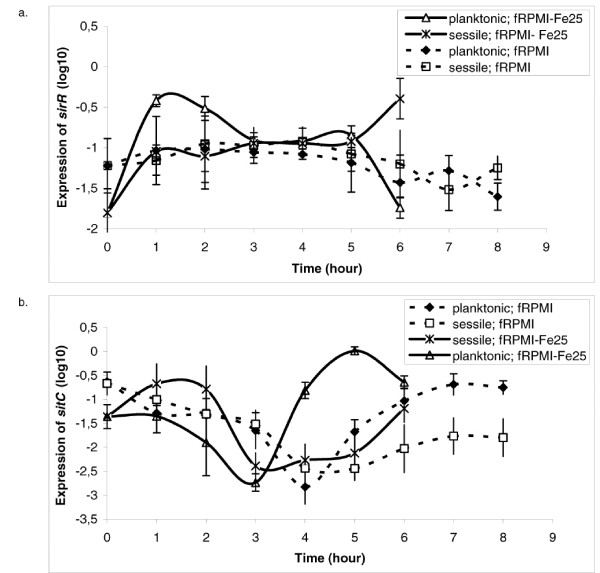
In vitro gene expression of sirR (a) and sitC (b) in sessile versus planktonic bacteria. Gene expression is quantified as log10 (cDNA/gDNA) in the y-axis. Time is given in hours in the x-axis. The line that links the data points helps to clarify the results at each time point measured. The error bars represent standard deviations. Fifteen samples from three independent cultures were assessed at each time point. Bacteria were pre-incubated overnight in fRPMI and incubated together with catheter fragments in fRPMI (sessile: dotted line with empty squares; planktonic: dotted line with filled diamonds) or in fRPMI-Fe25 (sessile: full line with crosses; planktonic: full line with empty triangles).